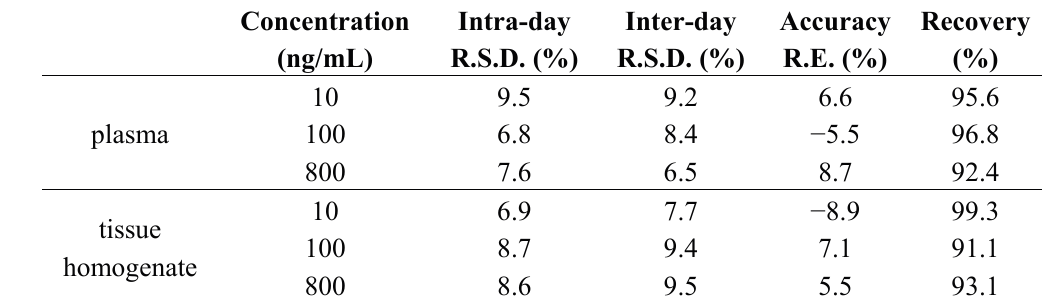
Figure 1. Typical chromatograms of caudatin. ( A ) blank plasma; ( B ) blank plasma spiked with caudatin and IS; ( C ) 0.5 h plasma sample after administration of caudatin at a dose of 20 mg/kg; ( D ) blank liver tissue homogenate; ( E ) blank liver tissue homogenate spiked with caudatin and IS; ( F ) 0.5 h liver homogenate sample after administration of caudatin at a dose of 20 mg/kg. Table 1. Accuracy, precision and recovery of caudatin in rat plasma and tissue homogenate (n =